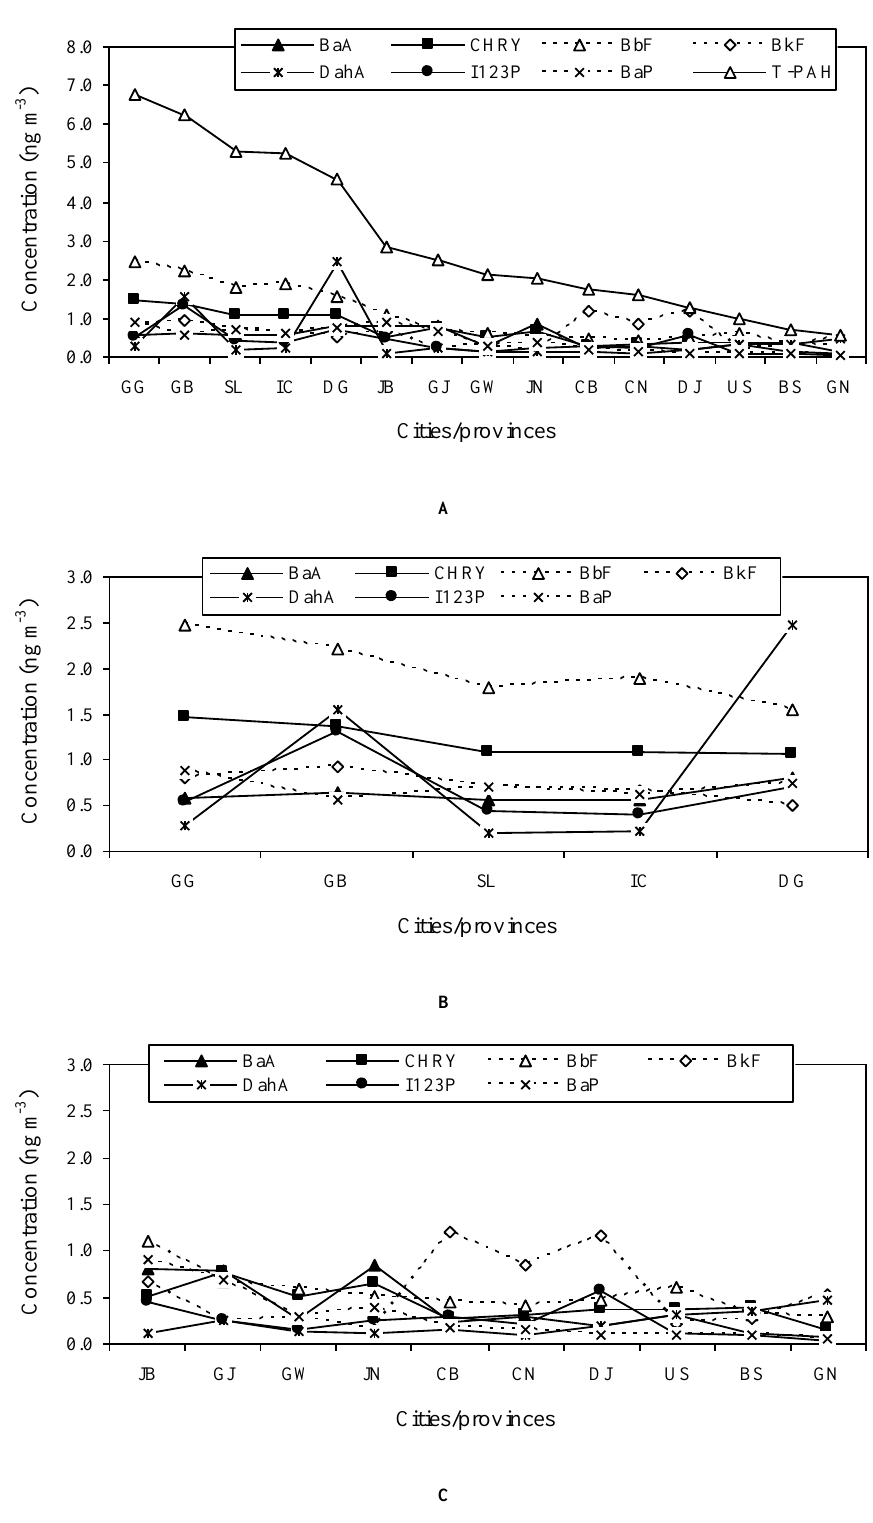
FIGURE 2 . Spatial distribution of the PAH concentrations among seven cities and eight provinces in Korea (2006–2008). (A) Comparison of T-PAH and individual species for all cities/provinces; (B) comparison of individual PAH species for high concentration groups; (C) comparison of individual PAH species for low concentration